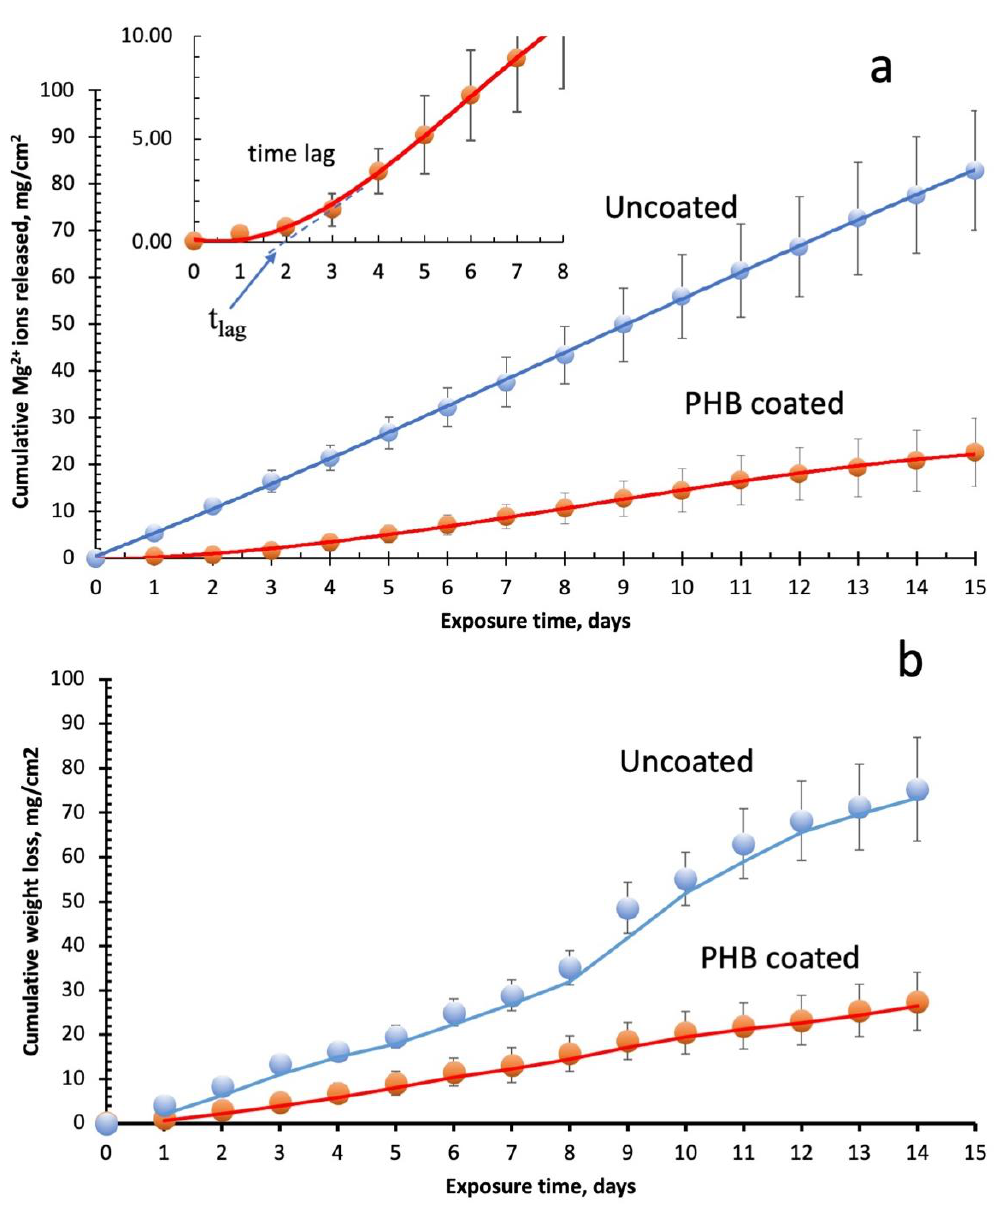
Figure 4. Cumulative Mg ion release ( a ) and weight loss ( b ) kinetics during corrosion tests. Details of the initial kinetic and time lag in the upper left part of the figure.